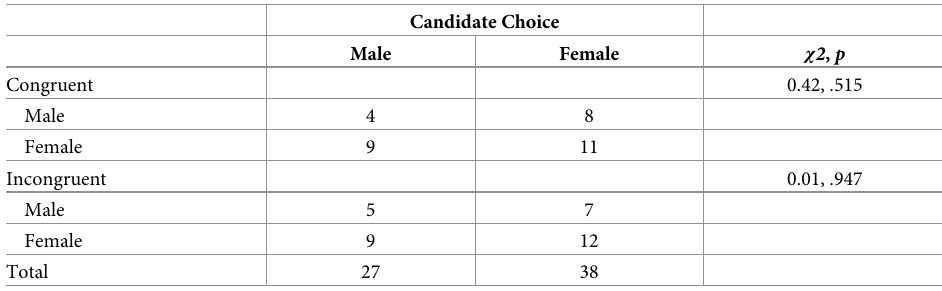
Table 2. Candidate choice by embodiment and participant gender in Study